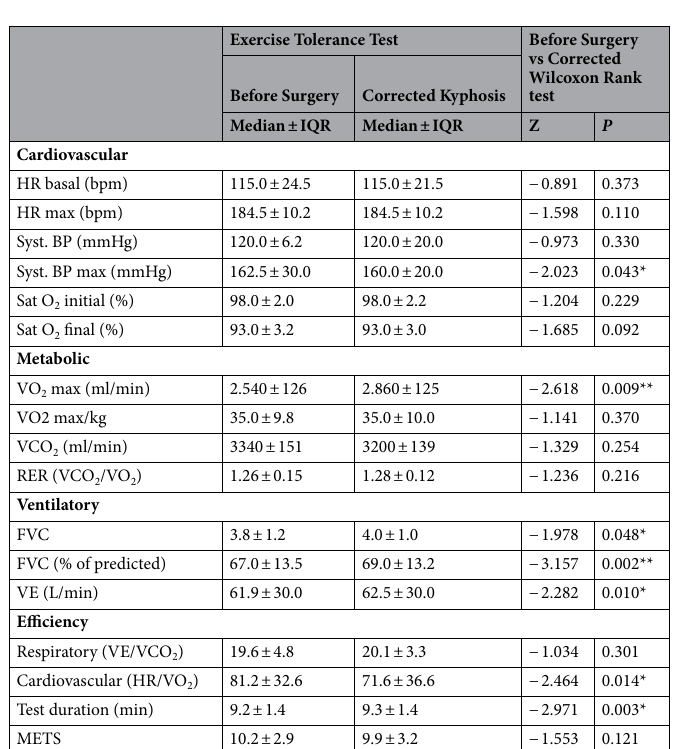
Table 2. Results of the tolerance exercise test in patients with corrected and uncorrected Scheuermann thoracic hyperkyphosis. IQR: Interquartile range HR: heart rate; BP: blood pressure; Sat O 2 : saturation O 2 ; Pu02: pulse of oxygen; VO2 max: oxygen uptake at maximal exercise; VC02: carbon dioxide output; VE/VCO 2 : expiratory volume and carbon dioxide output ratio; RER: respiratory exchange ratio; VE, ventilation; VE/VO2: ventilatory efficiency; HR/VO 2 : cardiovascular efficiency; mmHg: millimetres of mercury; % of predicted: percentage of predicted FVC according to age, sex, height, mass and ethnicity; L/min: litres per minute); METS: metabolic equivalents of tasks. * P < 0.05.